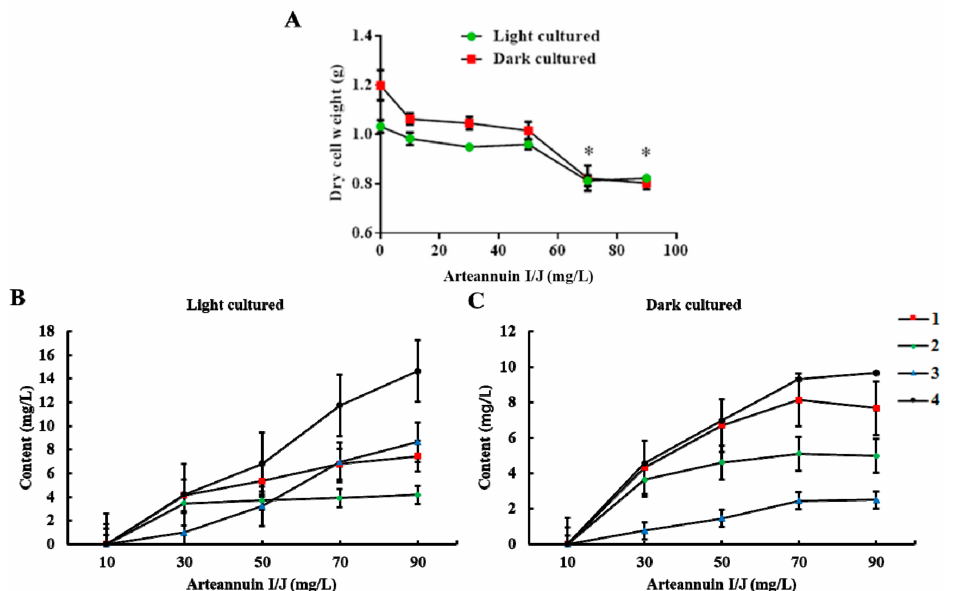
Figure 3. Effects of arteannuin I/J dosage on cell growth and the content of new products. All values present the mean of three cultures replicated three times (* p < 0.05 compared with the control group by Tukey’s test). ( A ) Effects of arteannuin I/J dosage on cell growth under light and dark cultured conditions; ( B ) Effects of arteannuin I/J dosage on the content of 1–4 under light cultured condition; ( C ) Effects of arteannuin I/J dosage on the content of 1–4 under dark cultured